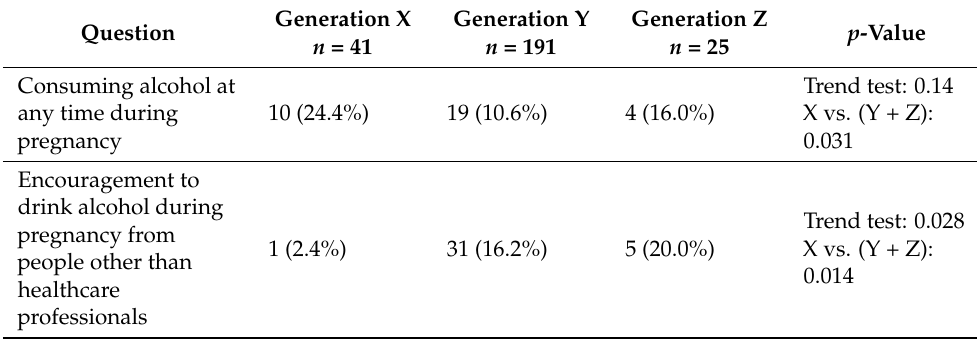
Table 5. Personal experiences during